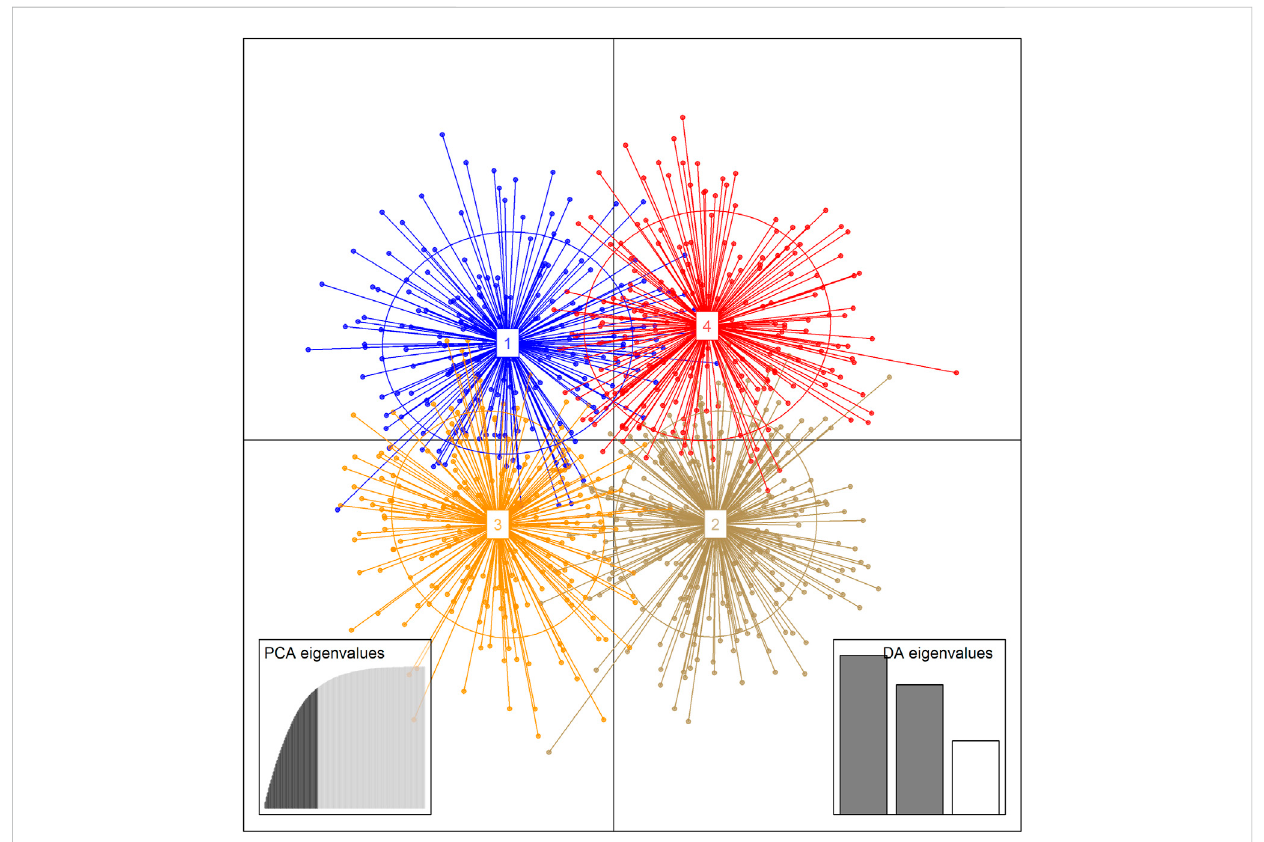
FIGURE 6 Scatterplot of the fi rst two Linear Discriminants (LD) showing genetic clusters for 954 indigenous goat sampled in the three vegetation zones of Benin applying unsupervised Discriminant Analysis of Principal Components (DAPC). Each ellipse represents a priori cluster and each dot an individual.